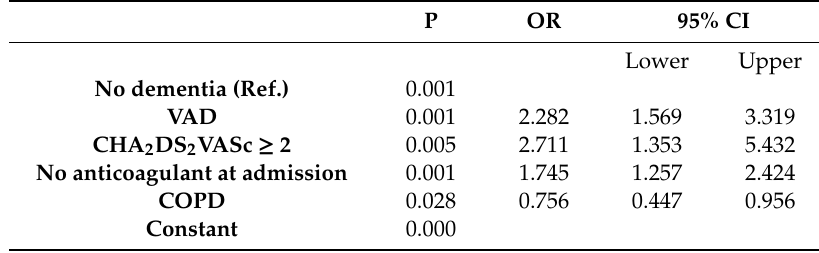
Table 3. Logistic regression analysis results considering in-hospital stroke / TIA as dependent variable. P OR 95% CI Lower Upper No dementia (Ref.) 0.001 VAD 0.001 2.282 1.569 3.319 CHA 2 DS 2 VASc ≥ 2 0.005 2.711 1.353 5.432 No anticoagulant at admission 0.001 1.745 1.257 2.424 COPD 0.028 0.756 0.447 0.956 Constant 0.000 Legend: COPD = chronic obstructive lung disease; VAD = vascular